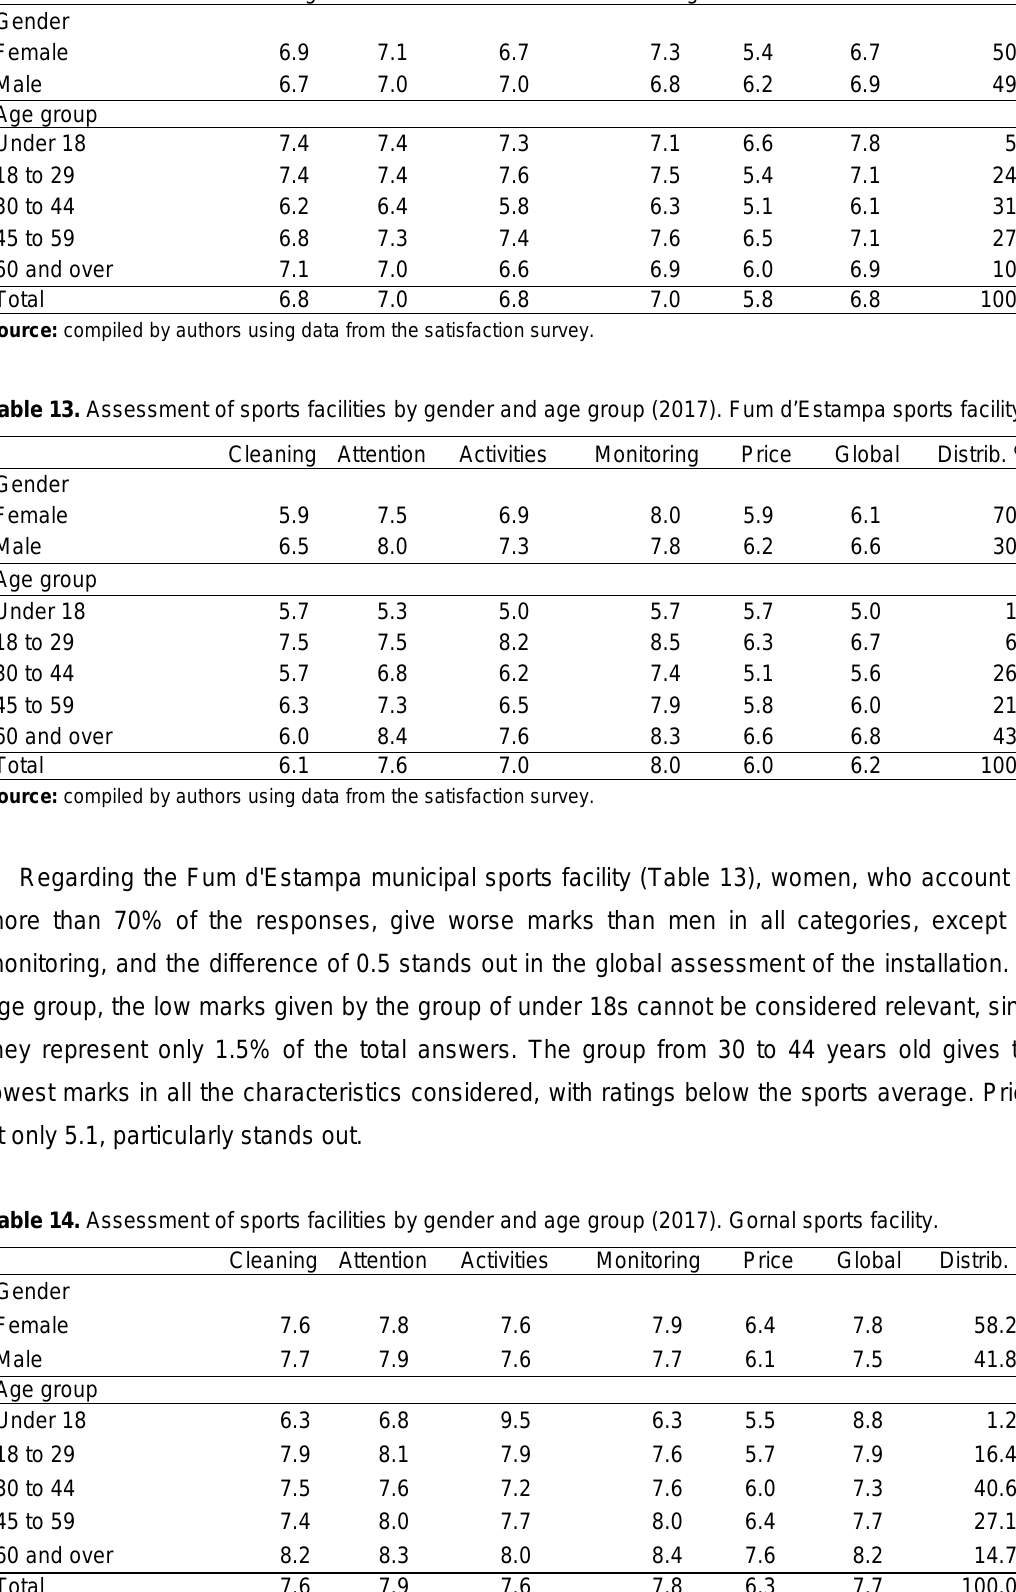
Table 12. Assessment of sports facilities by gender and age group (2017). Municipal swimming pools. Cleaning Attention Activities Monitoring